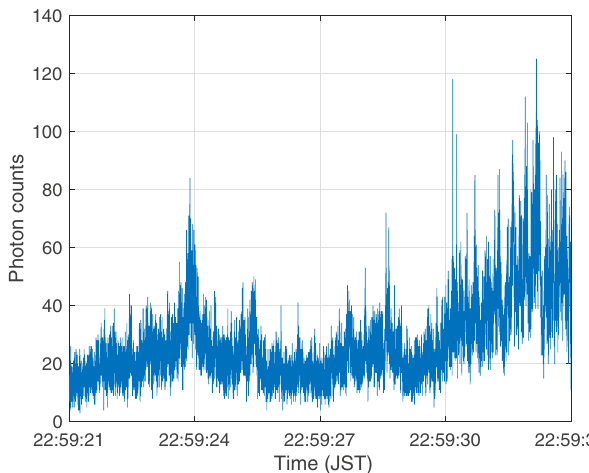
Fig. 3 Photon-count data from four single-photon counter modules. The solid navy-blue curve shows the number of photon counts every millisecond during a 12-s duration from 22:59:21 to 22:59:33 (JST) on 5 August